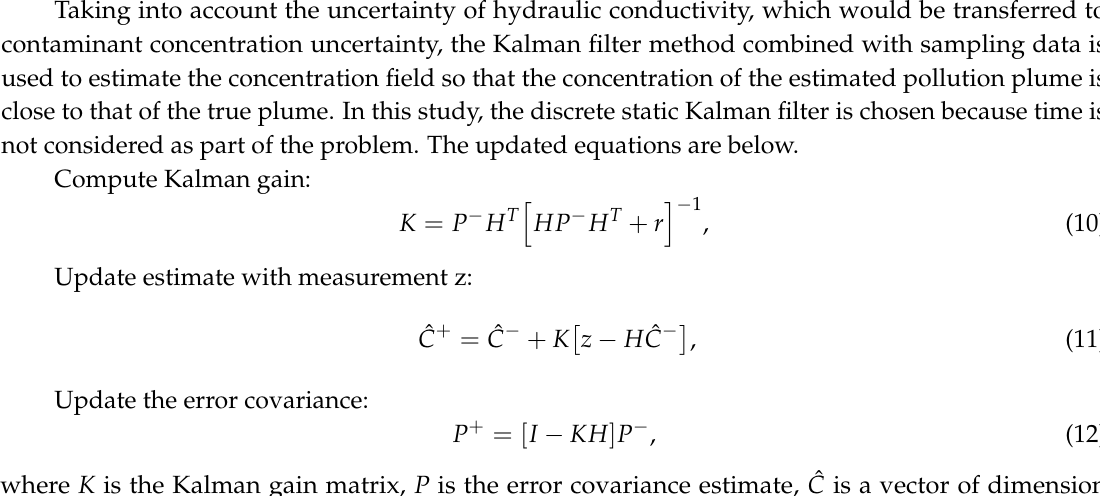
Figure 3. Generation diagram of the realization of superposed concentration